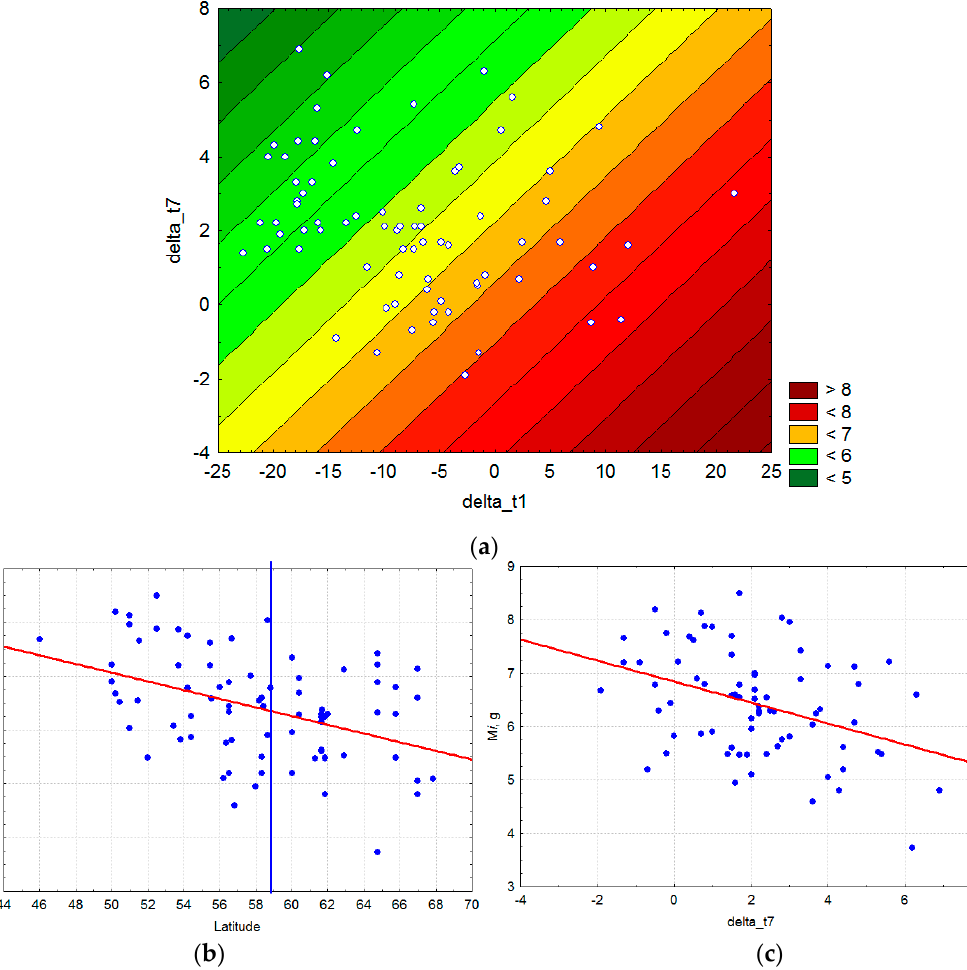
Figure 6. The dependence of M i on a provenance latitude ( a ) and the difference between July temperatures for the i -year and a multi-year mean of provenance ( b ) for 1999–2003 and 2010 (a year of seed measurements in the test site). The blue line is the latitude of the test